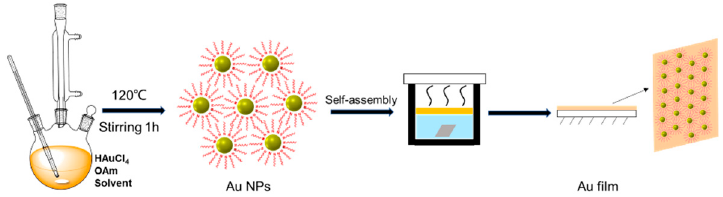
Scheme 1. Schematic diagram of synthesis and self-assembly process of Au NPs.